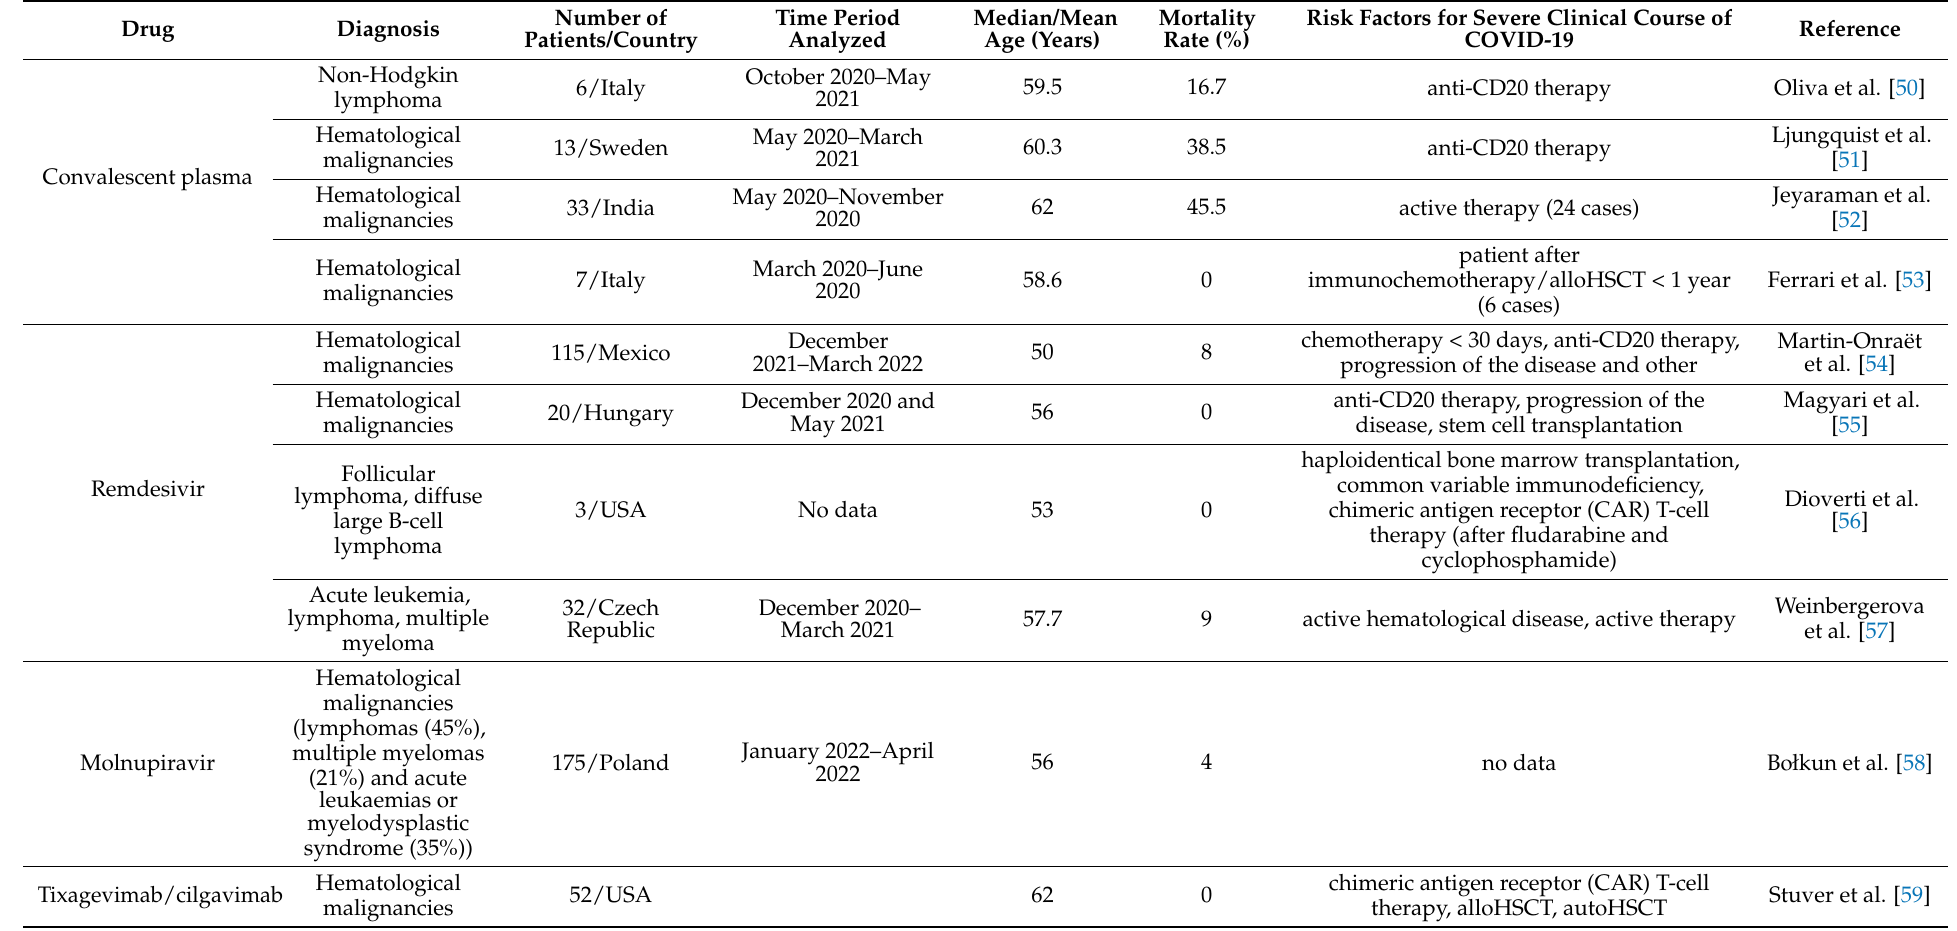
Table 1. Treatment of COVID-19 in patients with hematological